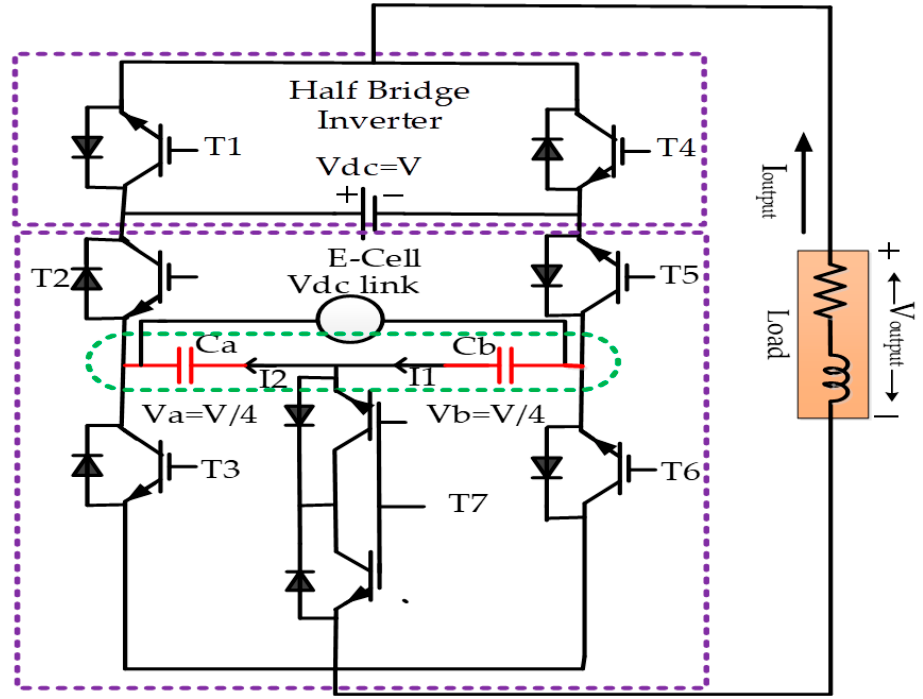
Figure 5. PEC-9 (nine–level Packed E-Cell) inverter topology.